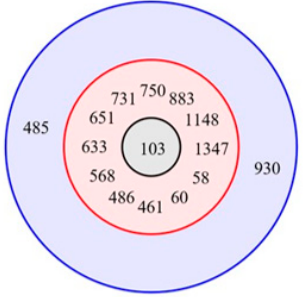
Figure 1. Eburst diagram of sequence types in clonal cluster 103. The diagram shows the single-locus variants (red ring) and the double-locus variants (blue ring) of sequence type (ST) 103 (grey circle in the center) in clonal cluster 103.